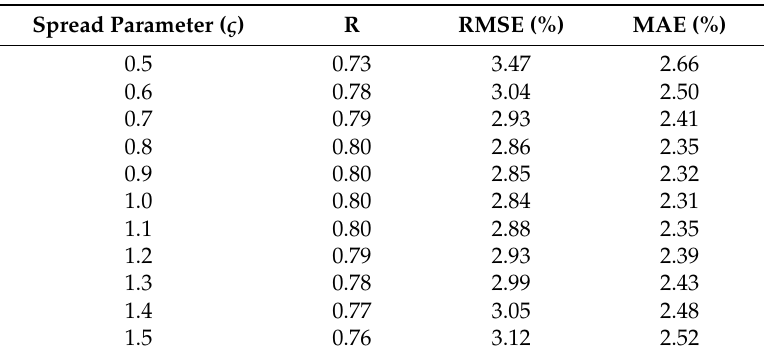
Table 2. The effect of spread parameter on GRNN for testing Dataset 1.